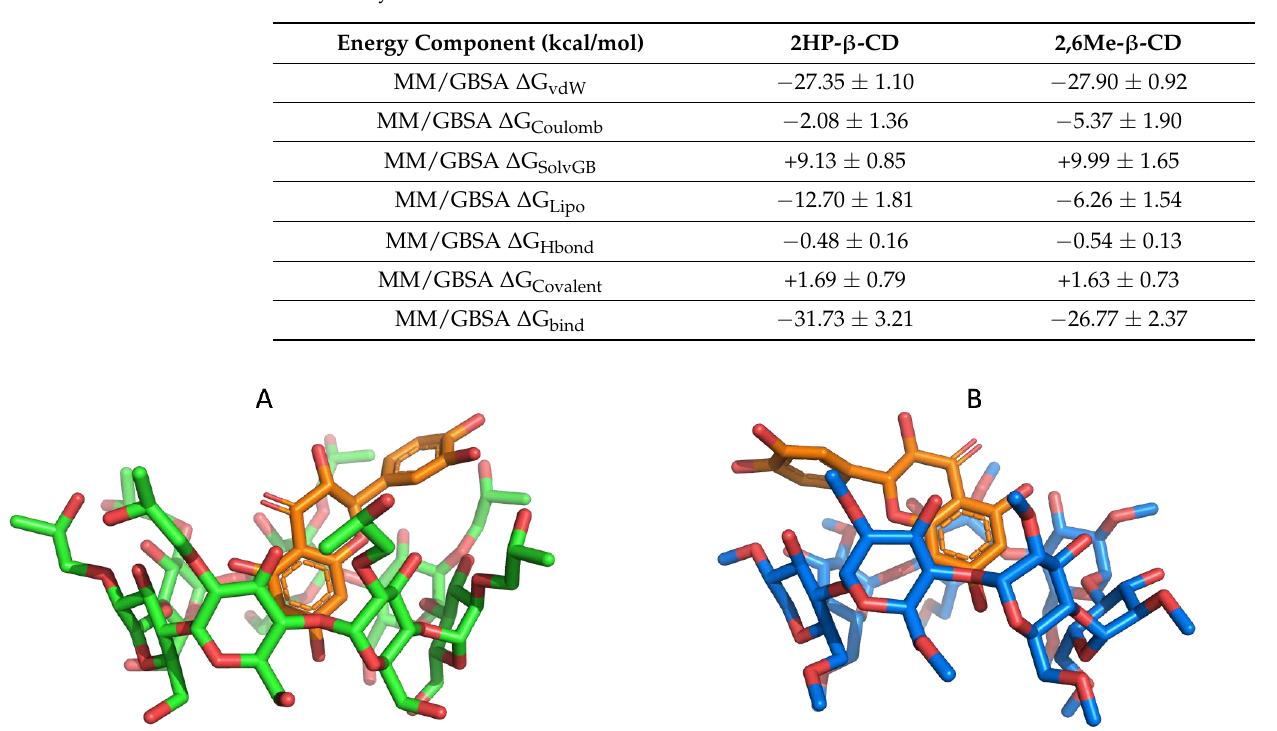
Table 9. Binding free energy analysis for the QUE/2HP- β -CD and QUE/2,6Me- β -CD complexes as obtained by the MM/GBSA calculations.